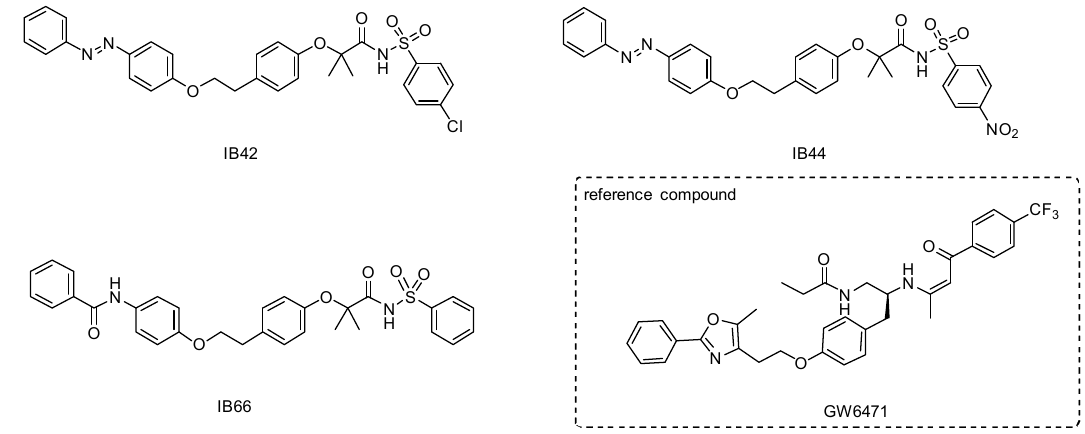
Figure 1. Chemical structures of phenylsulfonimide derivatives IB42, IB44, and IB66 tested in this study, and GW6471 used as reference PPAR α antagonist.